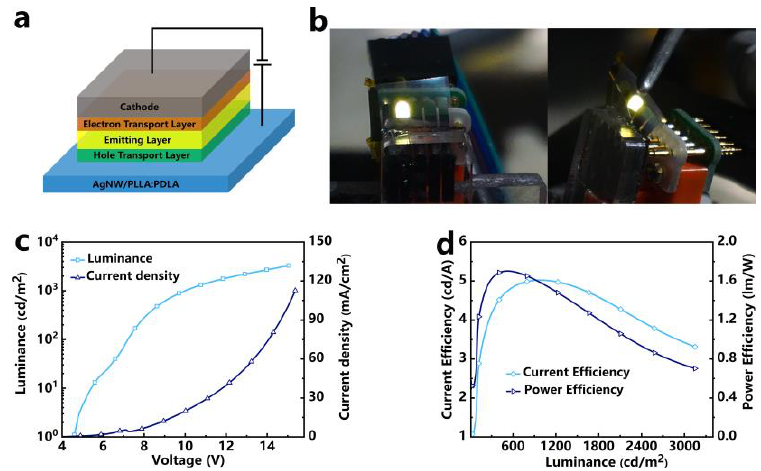
Figure 5. ( a ) Schematic illustration of the OLEDs structure and ( b ) photographs of turned-on OLEDs based on the AgNW/PLLA:PDLA film. ( c ) Luminance-voltage-current density curves and ( d ) current efficiency-luminance-power efficiency curves of the OLEDs.